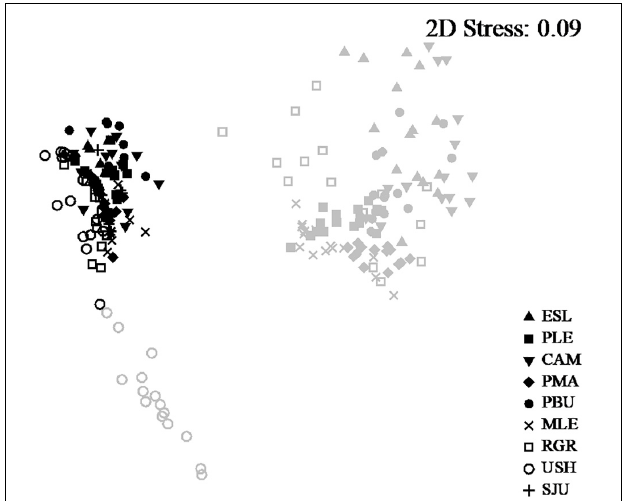
FIGURE 2 | n-MDS of all locations and both intertidal levels. Samples from LT in gray and MT in